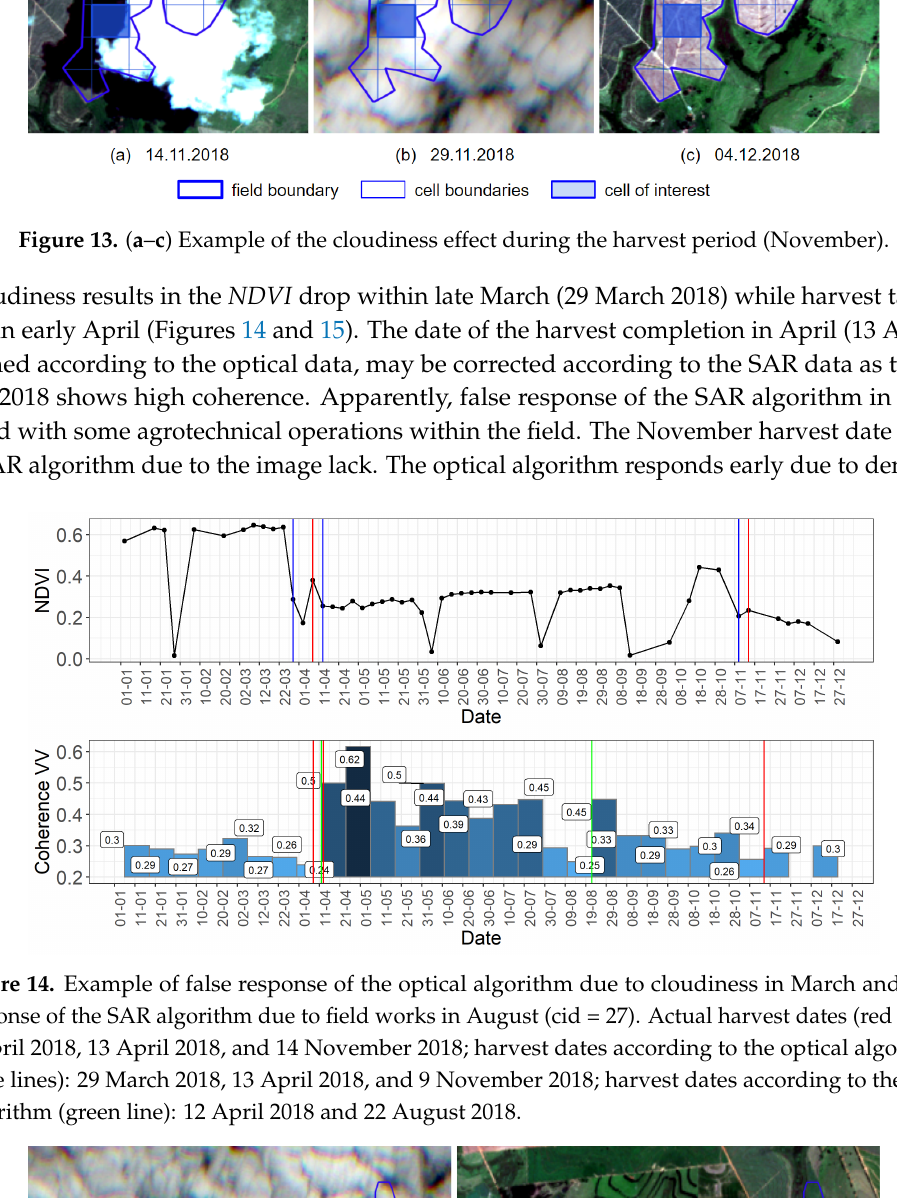
algorithm (green line): 12 April 2018 and 22 August 2018.